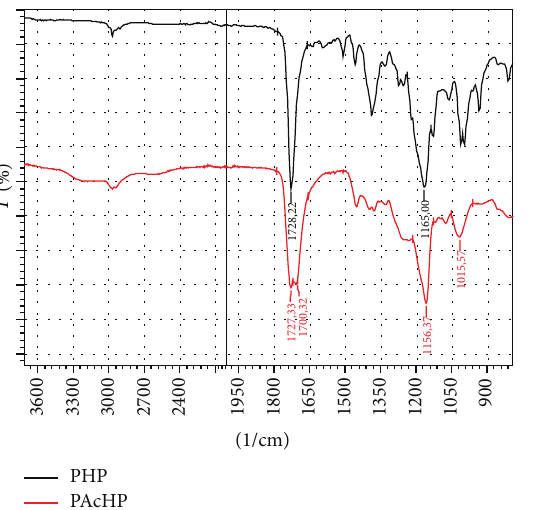
Figure 1: FTIR spectra of PHP (black line, upper) and PAcHP (red line, bottom) obtained from bulk polymerization.